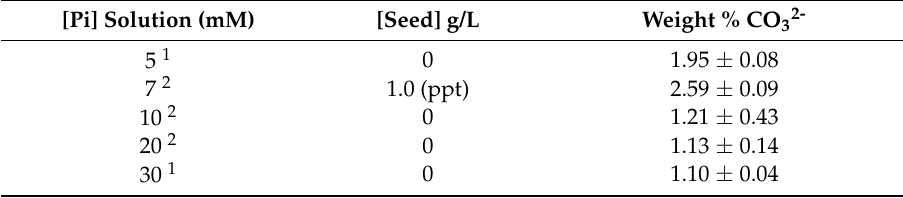
Table 9. Inorganic carbon coulometry measurement of weight percent carbonate (CO 32 − ) [Pi] Solution (mM)